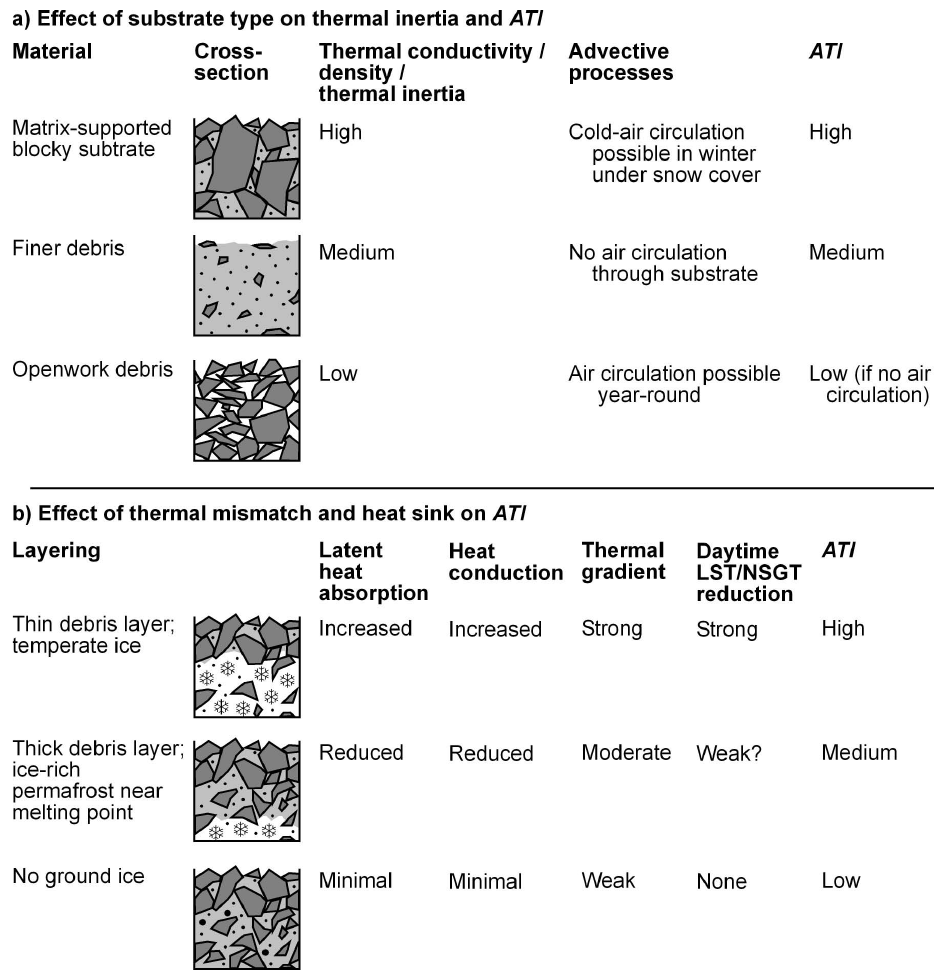
Fig. 4. Effects of substrate type, thermal mismatch and presence of a heat sink on thermophysical properties, thermal conditions and ATI under dry, snow-free conditions in summer: a schematic overview. ATI is subject to the combined effects of thermal inertia as a thermophysical property and seasonal as well as diurnal heat transfer processes between the ground surface and greater